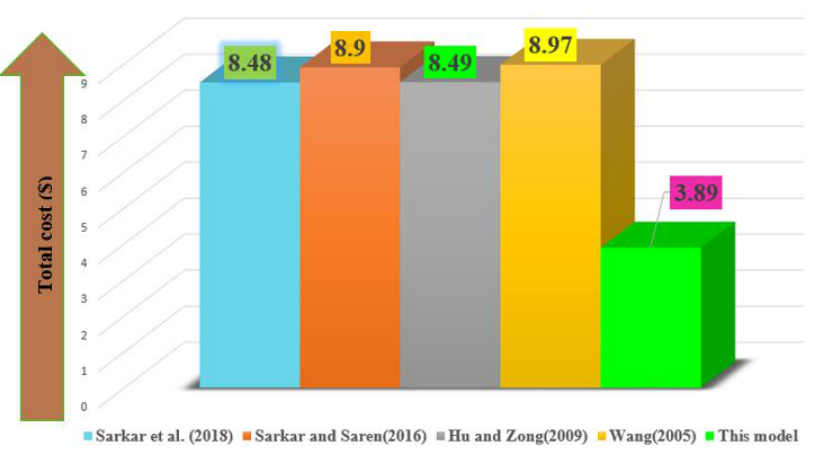
Figure 2. Graphical representation of cost for different existing literature.